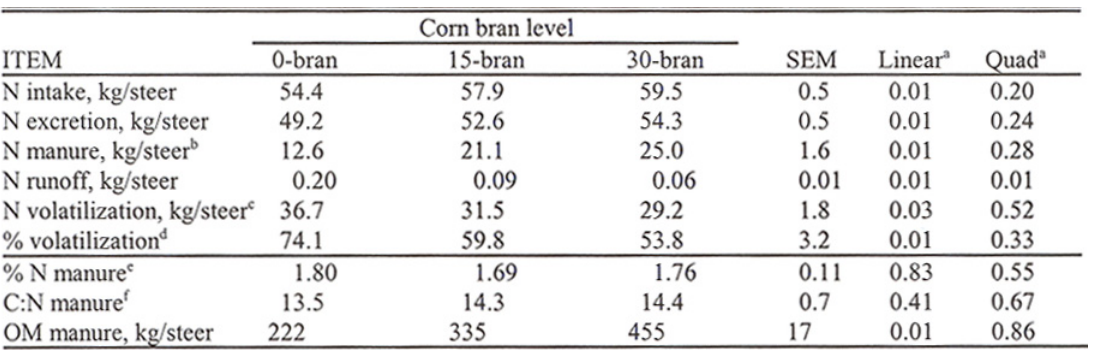
Effects of Dietary Corn Bran on N Balance in the Feedlot and Manure Characteristics for Steers Fed from October to June (Experiments 1 and 2)